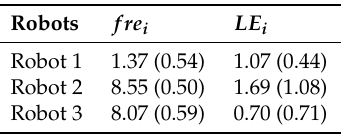
Figure 6. The curves for the localization errors for Case 2. Table 4. Mean (standard deviation) results in communication frequency (%) and localization error (m) based on 30 runs for Case 2.